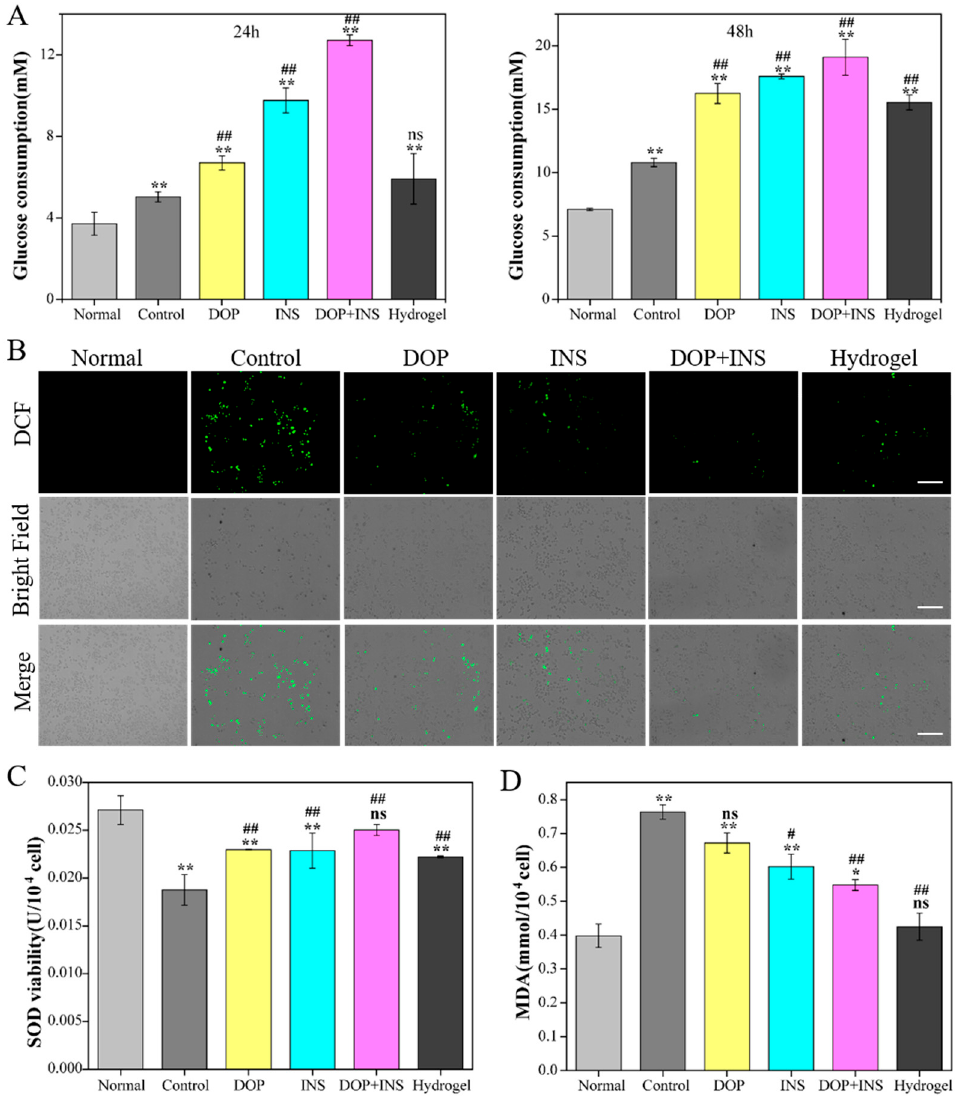
Figure 7. Effect of different formulations on glucose consumption ( A ), ROS ( B ), SOD viability levels ( C ) and MDA levels ( D ) in high-glucose-induced HL-7702 cells (* p < 0.05, ** p < 0.01, compared with normal group; # p < 0.05, ## p < 0.01, compared with control group; ns means no significance).